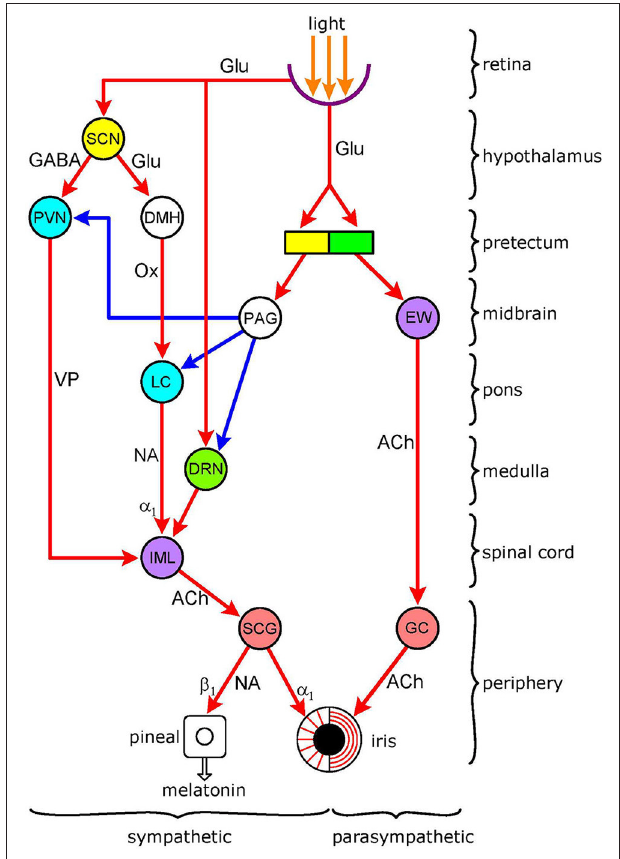
FIGURE 1 | Functional organization of autonomic pathways controlling the pupil. The encircled areas represent nuclei and ganglia. Retinoreceptive light-sensitive relay nuclei (yellow): SCN (suprachiasmatic nucleus); pretectum. Retinoreceptice light-sensitive premotor autonomic nuclei (green): parasympathetic–OPN (olivary pretectal nucleus); sympathetic–DRN (dorsal raphe nucleus). Premotor autonomic nuclei (blue): PVN (paraventricular nucleus); LC (locus coeruleus). Preganglionic nuclei (purple): parasympathetic–EW (Edinger-Westphal nucleus); sympathetic–IML (intermedio-lateral column). Integrative relay nuclei (white): DMH (dorso-medial hypothalamus); PAG (periaqueductal gray. Autonomic ganglia (pink): sympathetic–SCG (superior cervical ganglion); parasympathetic–GC (ganglion ciliare). Connections are shown by arrows: red-excitatory; blue-inhibitory. Neurotransmitters : Glu (glutamate); GABA (y-amino-butyric acid); Ox (orexin); VP (vasopressin); NA (noradrenaline); ACh (acetylcholine). Adrenoceptors (postsynaptic): α 1 (excitatory); β 1 (excitatory). There are 5 light-modulated autonomic pathways : (1) parasympathetic (light-stimulated): OPN → EW → GC → sphincter pupillae muscle; (2) sympathetic (light-inhibited): pretectum → PAG → sympathetic premotor nuclei (PVN, LC, DR) → IML → SCG → dilator pupillae muscle; (3) sympathetic (light-inhibited): SCN → PVN → IML → SCG → dilator pupillae muscle; (4) sympathetic (light-stimulated): SCN → DMH → LC → IML → SCG → dilator pupillae muscle; (5) sympathetic (light-stimulated): DR → IML → SCG → dilator pupillae muscle. Please note overlap of pathway 3 with control of melatonin synthesis. See text for